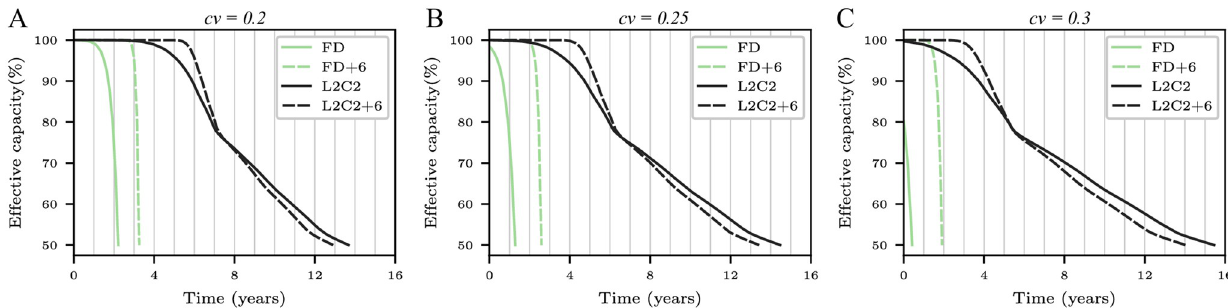
Fig 11. Effective capacity evolution over time until 50% of capacity is lost for three different cv. cv = 0.2 (A), cv = 0.25 (B), cv = 0.3 (C).